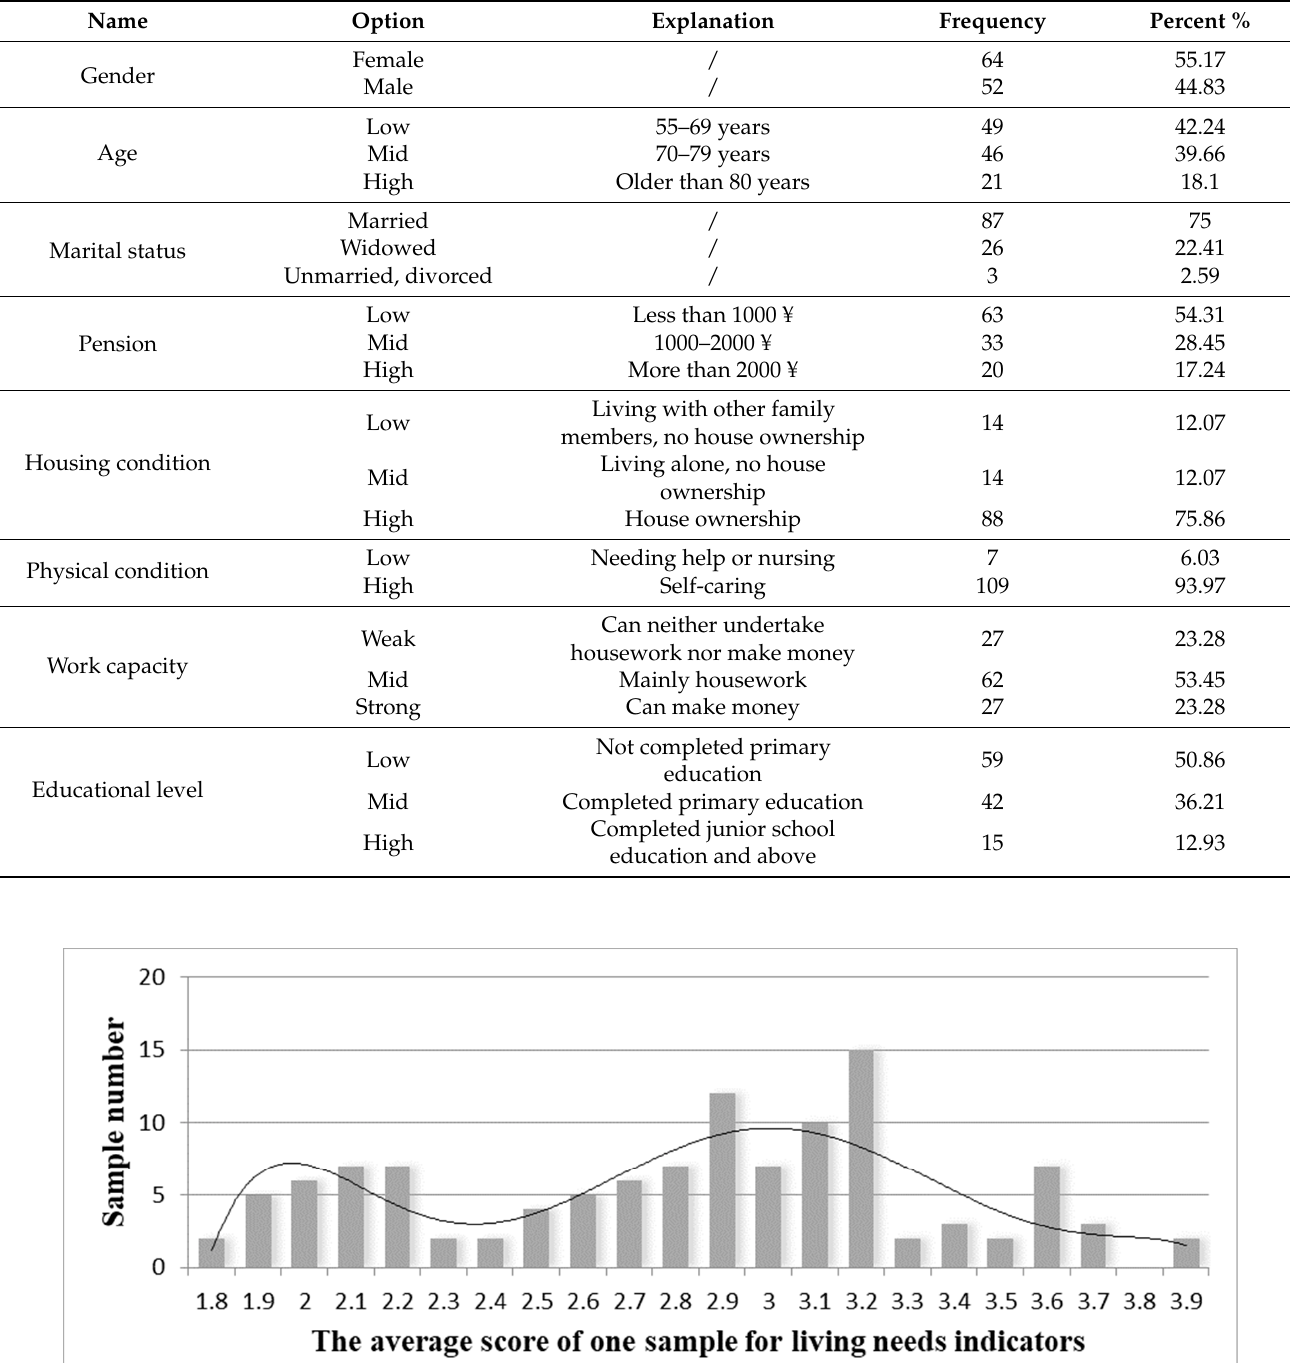
Figure 2. Frequency distribution based on the average score of one sample for production needs. The distribution based on the average score of one sample suggests that there are two categories of high need and low need both in production and living dimensions, which means it is necessary to classify and discuss the sample. To explore further com- prehensive differences in production- and living-needs indicators among urbanization samples, the study designed an analytical framework, with calculation steps of hierar- chical cluster analysis, one-way ANOVA test and Chi-square test performed by SPSS 23.0 (IBM Corporation, Armonk, NY, USA) for Windows and calculation results judged sta- tistically significant at p < 0.05: 1. Using hierarchical cluster analysis, which can classify samples according to the closeness degree without prior knowledge; with squared Euclidean distance and between-groups linkage, samples were respectively divided into two groups ac- cording to production and living need indicators. Taking the one-way ANOVA test, which can find whether the different levels of a control variable have a significant impact on the observed variable, to find need indicators with significant differences; comparing the average scores of the indicators with significant differences to de- termine which group is urbanized respectively in living and production dimension, and to assign urbanized values to the samples. 2. According to living and production urbanized values, the study constructed a four-quadrant model frame on human urbanization feature as follows: an Urban Group with both living and production needs urbanized (Group H-H); a Half-urban-half-rural Group with only living needs urbanized(Group H-L); a Half-urban-half-rural Group with only production needs urbanized (Group L-H); and a Rural group with both living and production needs not urbanized (Group L-L) (Figure 3). Each group’ final need indicators are determined according to its